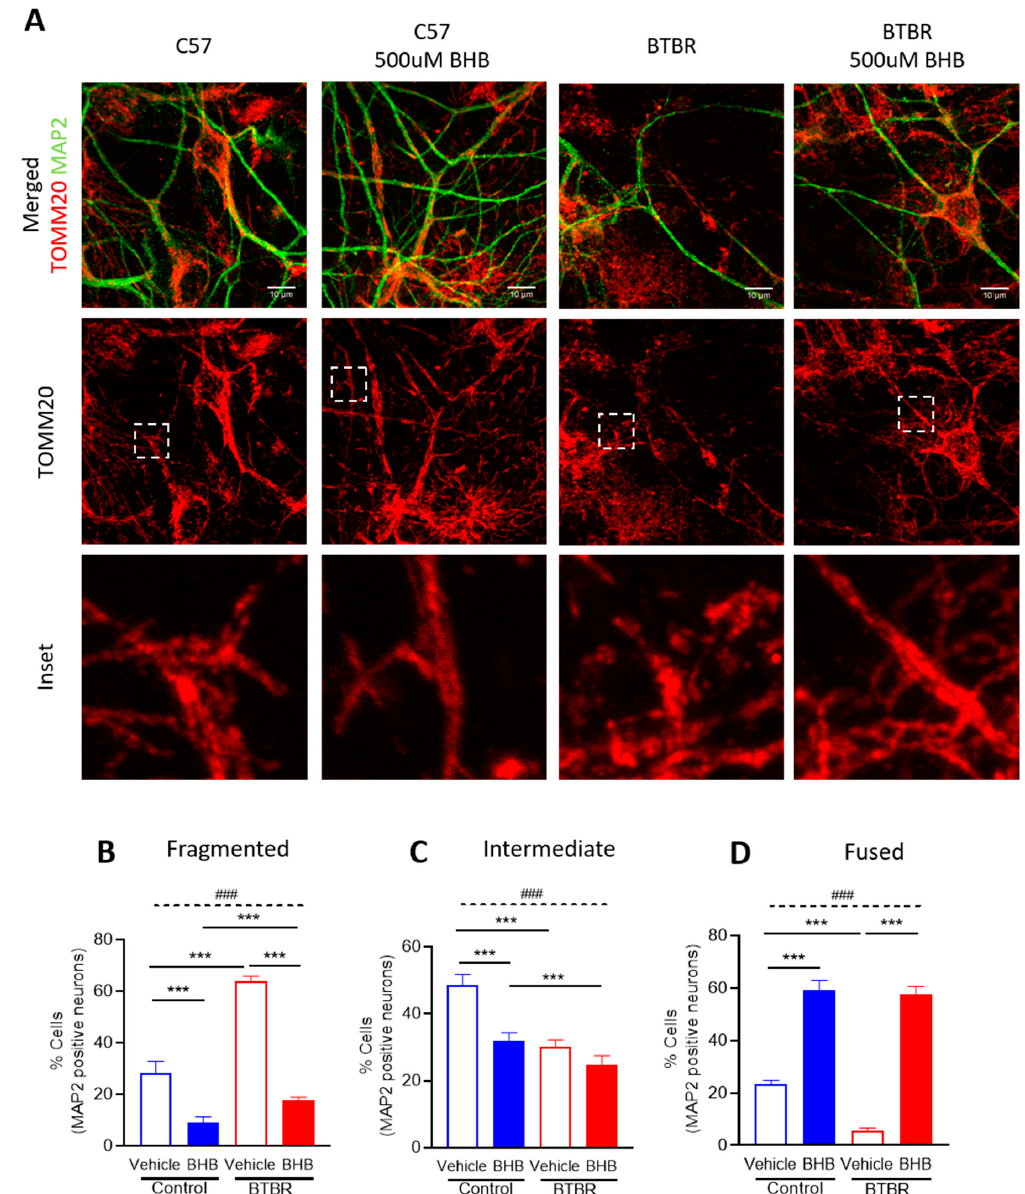
Figure 4. Mitochondrial morphology analysis in primary neuronal cultures from control and BTBR mice. ( A ) Representative confocal images of cortical neuronal cultures stained with antibodies against MAP2 (neurons, green) and TOMM20 (mitochondria, red). Dashed box highlights mitochondrial network in neurites (dendrites). Quantification of mitochondrial morphology ( B ) fragmented, ( C ) intermediate, and ( D ) fused in neurites in control and BTBR cultures from three independent replicates, treated as indicated. Data are shown as mean ± SEM. Data were analyzed by two-way ANOVA. The significant effects (main effects from two-way ANOVA) are presented as ### p < 0.001. Further, the significant differences between groups revealed by the post-hoc analysis are presented as *** p < 0.001.